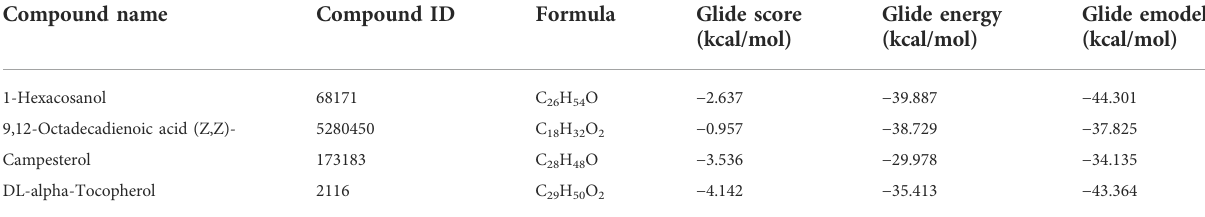
TABLE 2 Docking results with ligands in the caspase-3 (PDB:3GJQ)